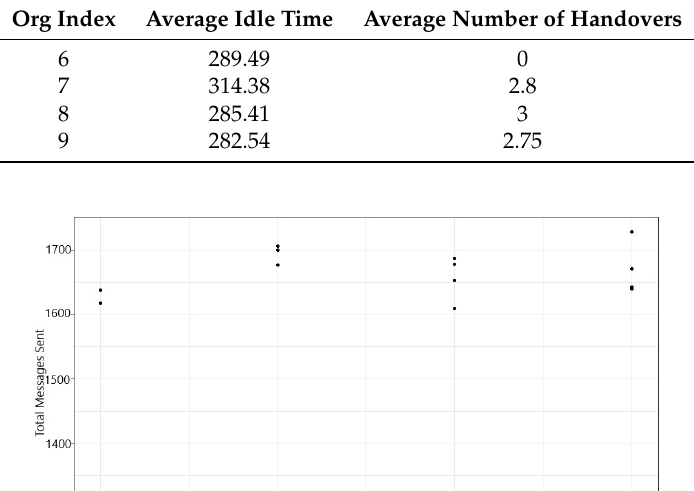
Table 7. Comparison of agent idle times.